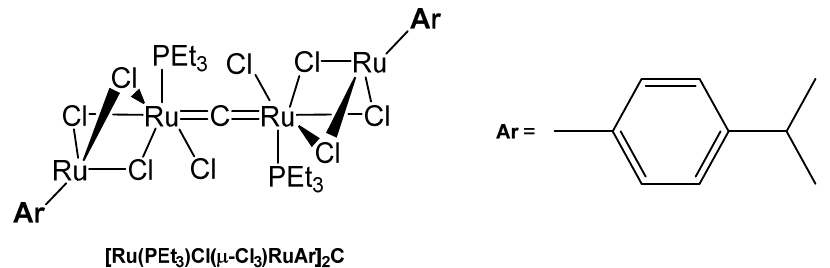
Figure 35. Selected structures of Rh=C=Rh complexes.